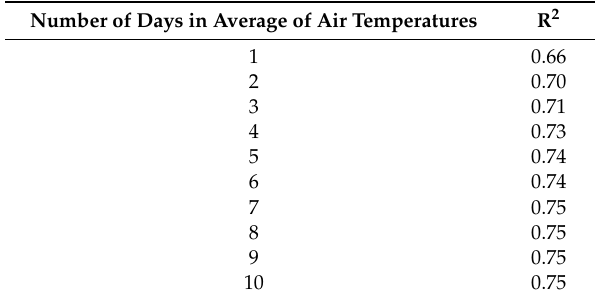
Table 2. Relationship between measured water temperatures and air temperatures averaged over different number of days based on regressions using both Canadian and United States lakes.